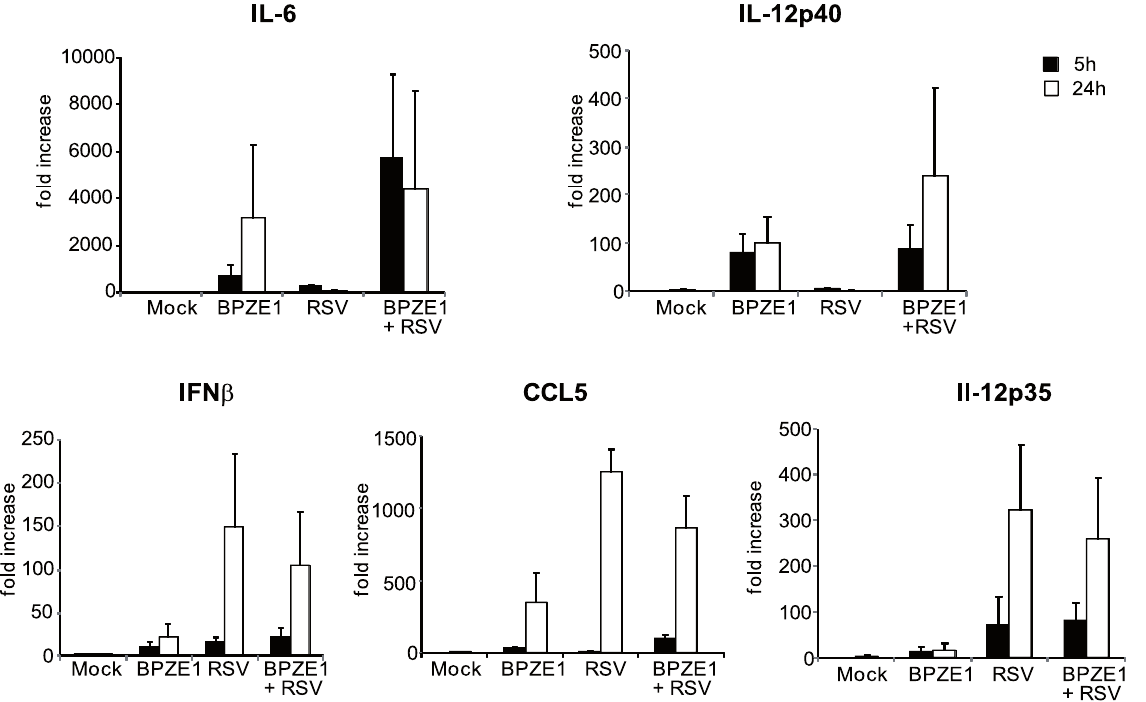
Figure 6. RSV- and BPZE1-induced IL-6, IFN b , CCL5, IL-12p40 and IL-12p35 gene expression in MDDC. MDDC were treated with BPZE1 (100:1), RSV (MOI of 1) or both. Mock-infected cells were added as control. Total RNA was extracted at the indicated time points. Kinetics of mRNA expression for p40 and p35 subunits of IL-12p70, IL-6, IFN b and CCL5 was evaluated by real-time quantitative RT-PCR. The mRNA transcripts were normalized with respect to the endogenous reference (human b actin) sample. Data were expressed as fold increase (mean 6 SEM of four experiments) with respect to mock-treated cells at 5 h.